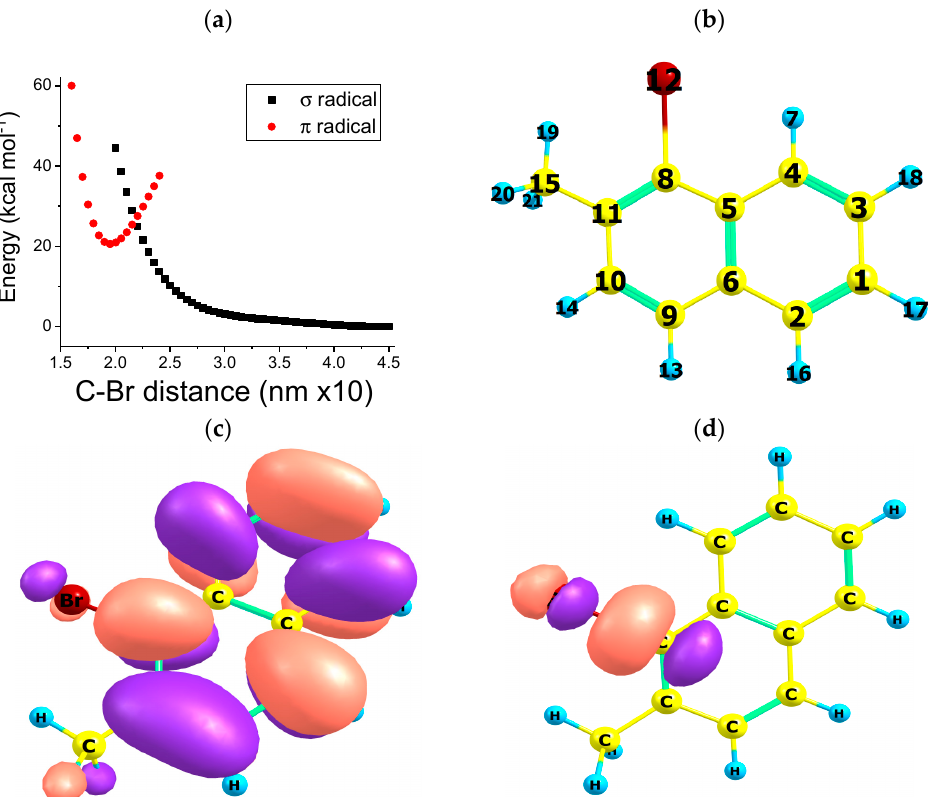
Figure 2. ( a ) Molecular potential energy of 2 𝐴 ’ ( 𝜎 radical, black squares) and 2 𝐴 ” ( 𝜋 radical, red circles) electronic states vs. C 8 − Br 12 distance for the 1-bromo-2-methylnaphthalene radical anion ( 2 ) UB3LYP/cc-pVTZ level of theory, using Barone and Cossi’s polarizable conductor model (CPCM) for the solvent acetonitrile ( b ) 1-bromo-2-methylnaphthalene radical anion structure of lower-energy molecular geometry ( c ) alpha SOMO of the 2 𝐴 ” ( π radical) electronic states ( d ) alpha SOMO of the 2 𝐴 ’ ( σ radical) electronic state.